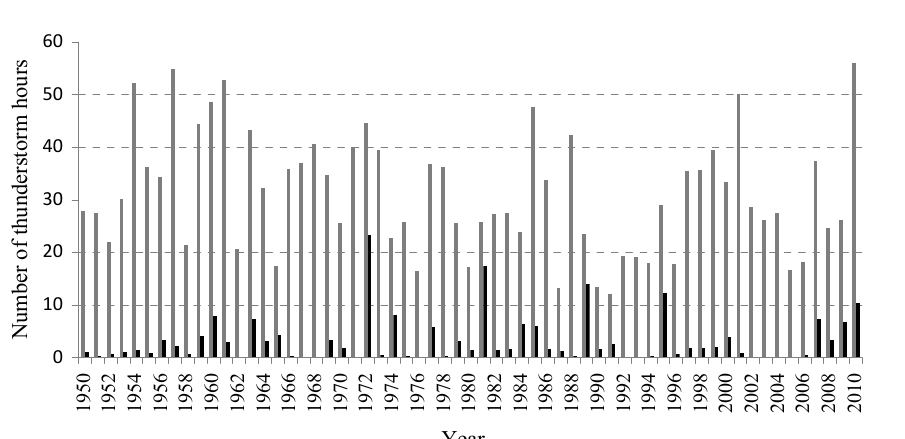
Fig. 5. Five-station mean duration of thunderstorms related to (black line) and not related to (grey line) southern cyclones in Estonia in 1950(cid:150)2010.